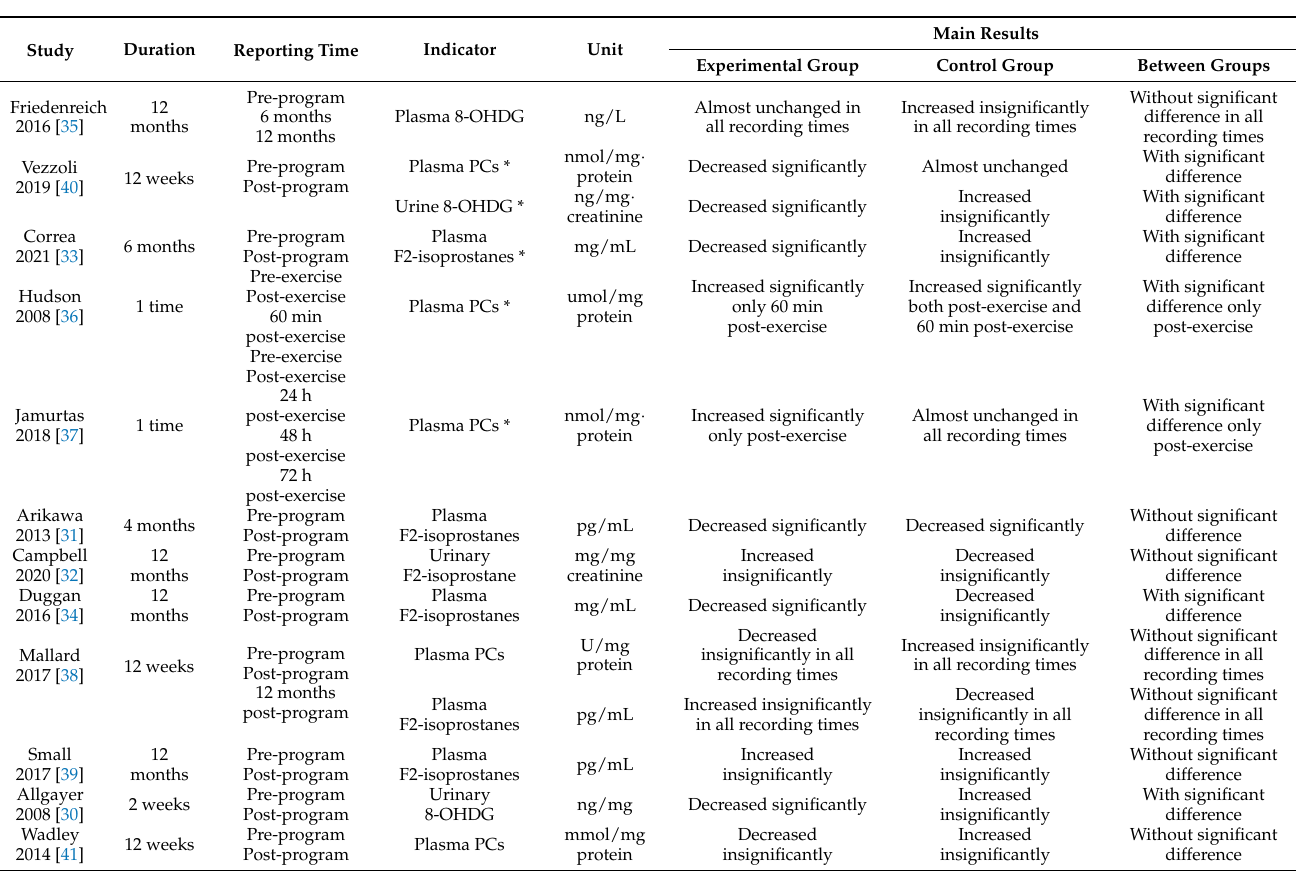
Table 2. Results of individual